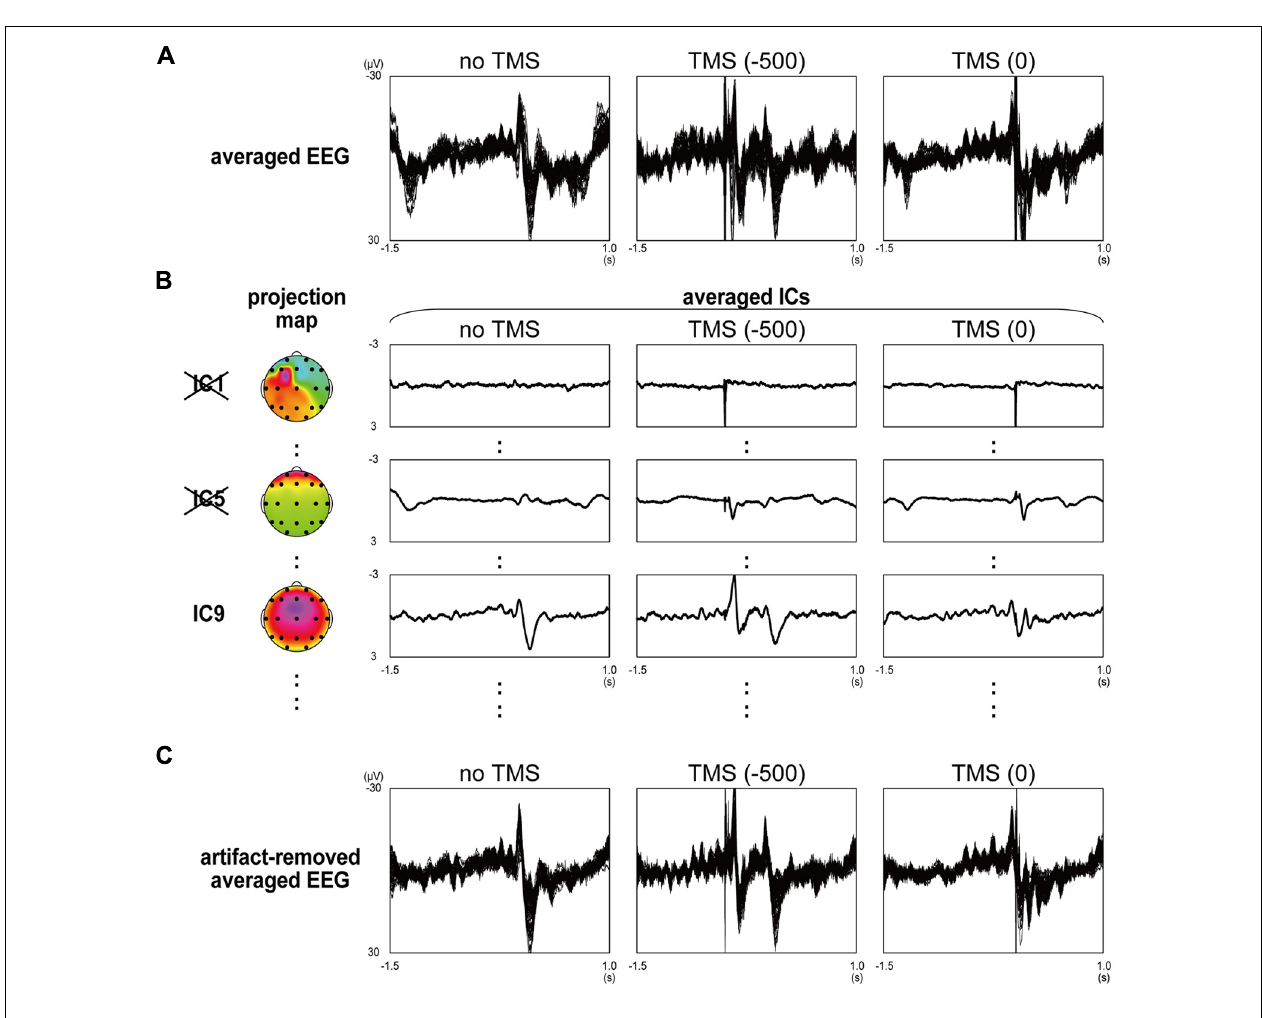
− 500 and 0 ms (middle and right panels) extracted from 61 EEG waveforms. In order of their variance size, the largest component (IC1), fifth largest component (IC5), and ninth largest component (IC9) were selectively shown. (C) Artifact-removed averaged EEG waveforms in no-TMS stop trials (left panel), stop trials with contralateral-TMS at